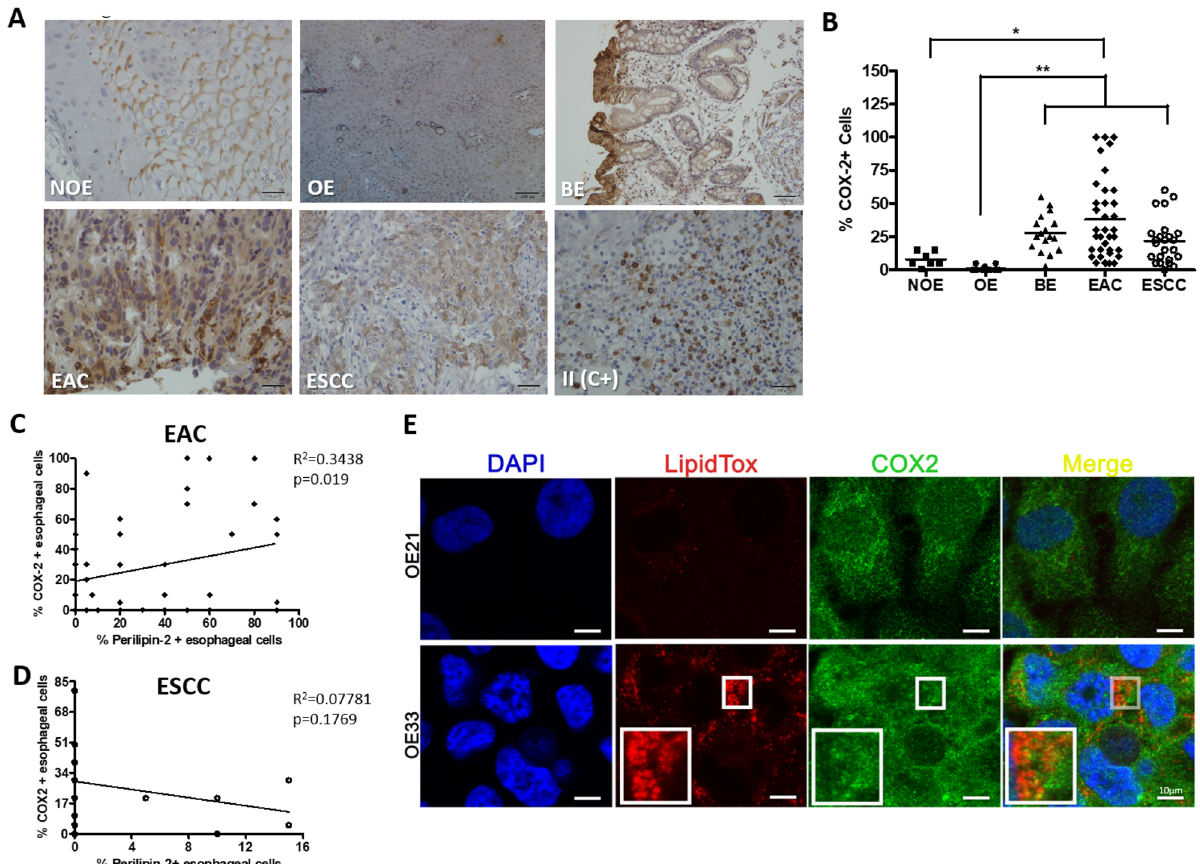
Figure 4. COX-2 expression pattern in esophageal samples and its relationship with Lipid Droplets (LD) presence. ( A ) Representative immunohistochemistry micrographs of esophageal samples from non-obese individuals (NOE; n = 10), obese individuals (OE; n = 21), Barrett’s esophagus (BE; n = 30), esophageal adenocarcinoma (EAC; n = 64) and esophageal squamous cell carcinoma (ESCC; n = 25) patients stained for Perilipin-2. The inflammatory infiltrate (II) was used as a positive control for COX-2 staining. ( B ) Graphical representation of the esophageal samples’ COX-2 staining score. Correlation analysis between Perilipin-2 and COX-2 percentage of positively stained cells ( C ) in the esophageal adenocarcinoma (EAC) and ( D ) in the esophageal squamous cell carcinoma (ESCC) samples. ( E ) Evaluation of LD (by using LipidTox) and COX-2 subcelullar localization, by immunofluorescence, in EAC (OE33) and in ESCC (OE21) cell lines. Zoom highlights LipidTox and COX-2 co-localization. Blue color represents DAPI staining; Red color represents LipidTox staining; Green color represents COX-2 staining. Experiments were performed in triplicate *p < 0.05; **p <